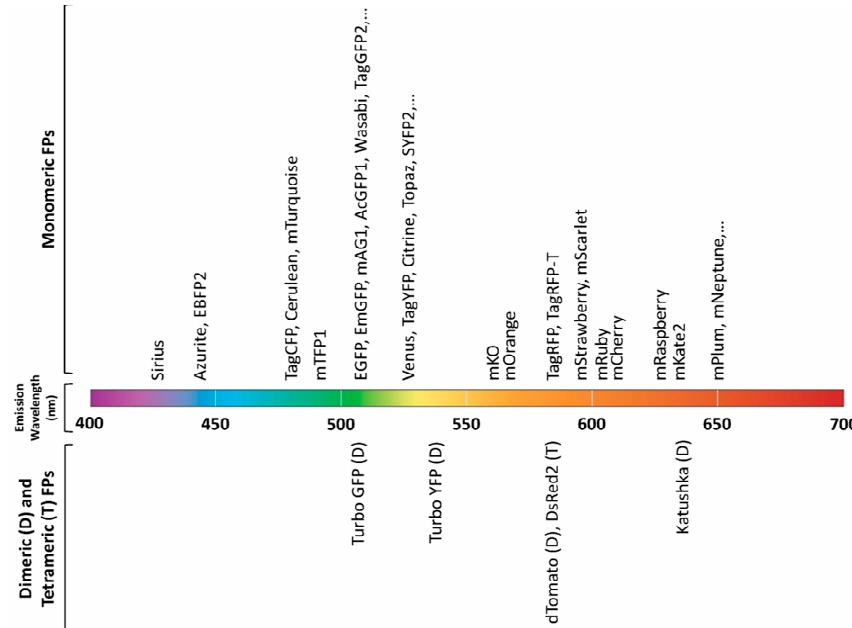
Figure 4. Spectral diversity of selected monomeric, dimeric and tetrameric fluorescent proteins (FPs). FPs are positioned according to their maxima of emission through 1P excitation. Please note that the list of FPs is not exhaustive. Adapted from [2].